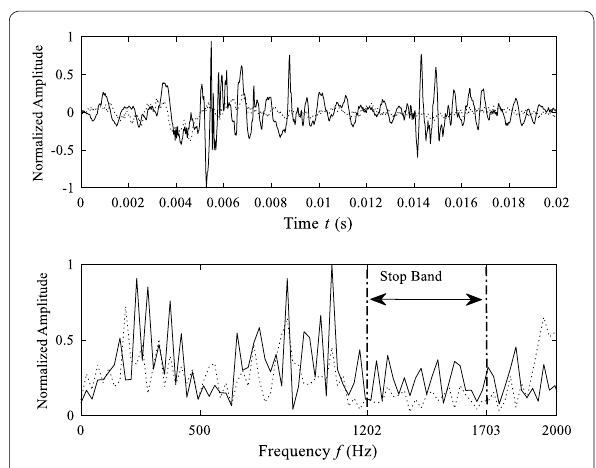
Figure 12 Experimental Stop Band derived at 1500